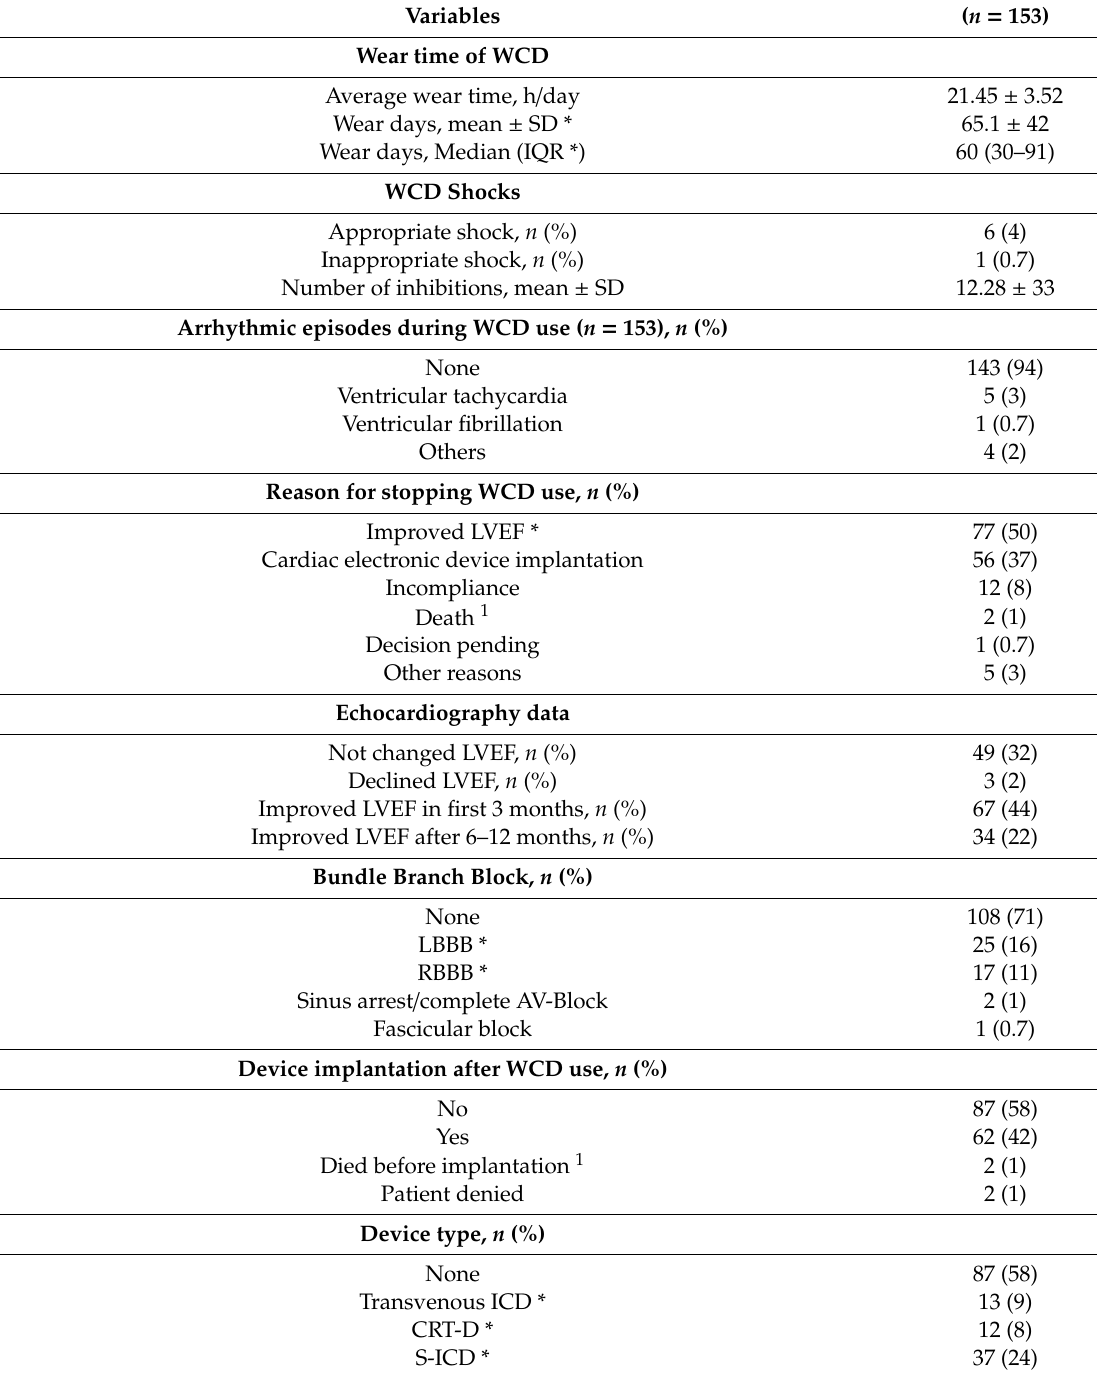
Table 2. Follow up data of patients during and after wearable cardioverter defibrillator (WCD)